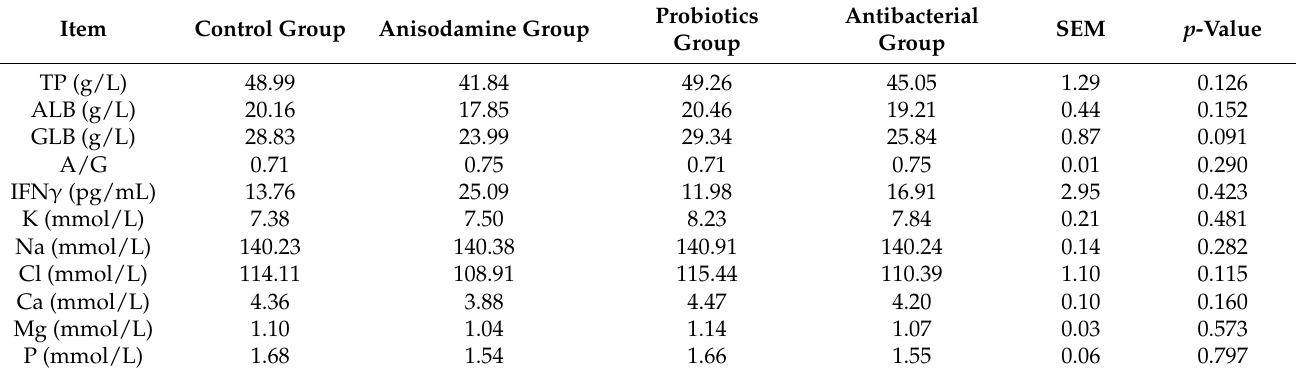
Table 4. Effects of different additives on serum biochemical parameters of high DM